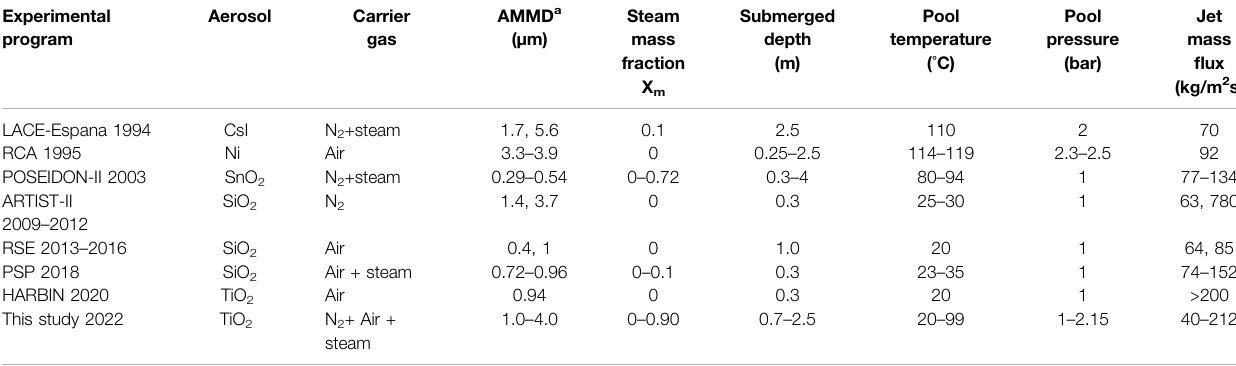
TABLE 1 | Summary of experimental study of pool scrubbing under the jet injection regime. Experimental program